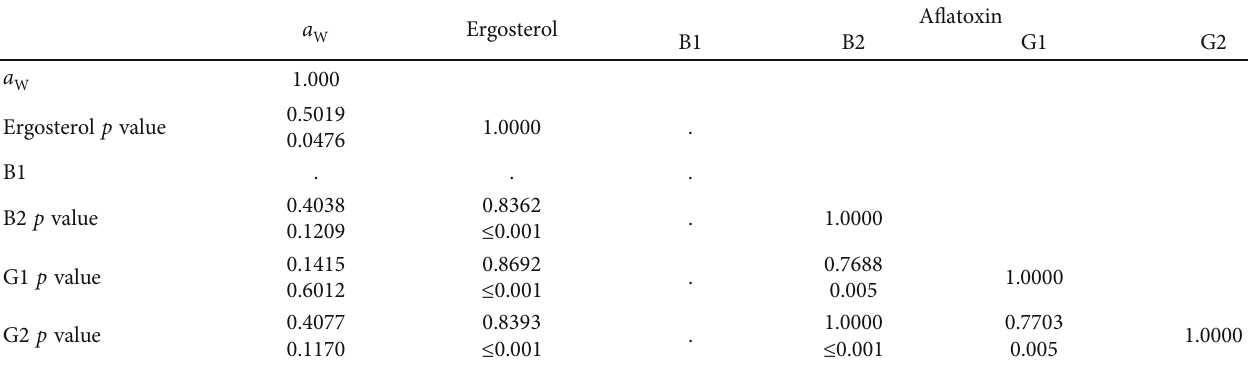
Table 4: Correlations between water activity, ergosterol, and a fl atoxin content in baobab